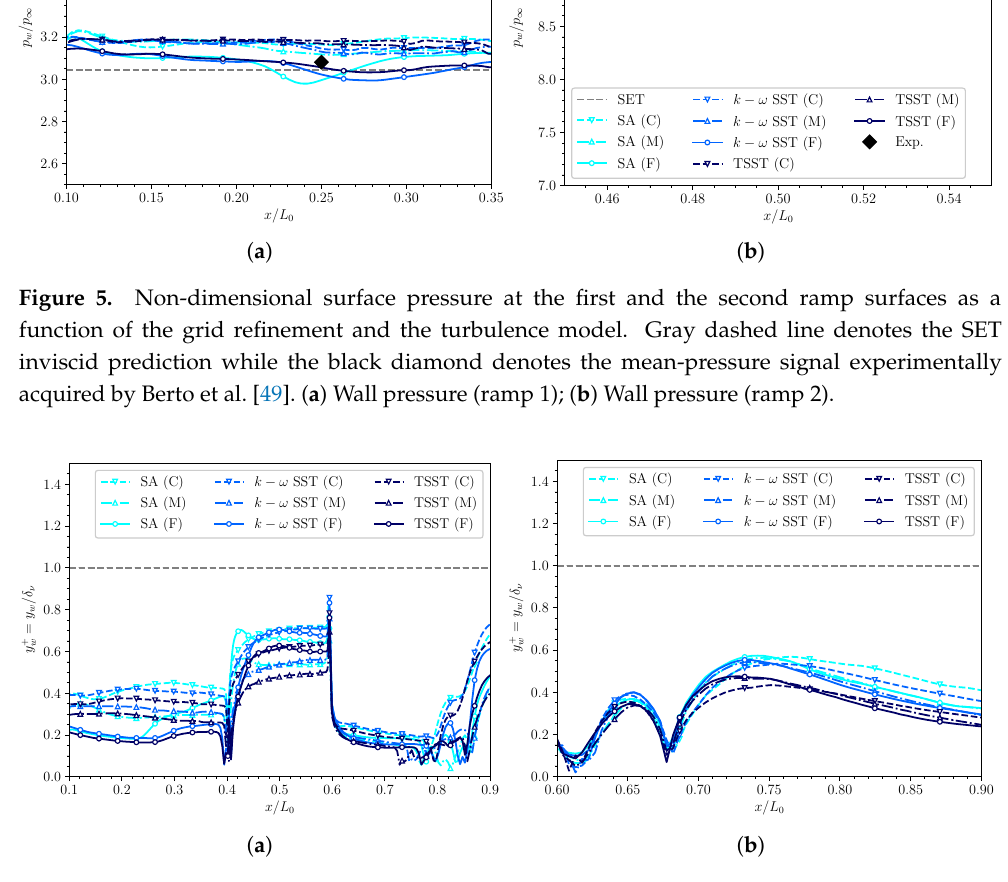
Figure 6. Scaled first off-the-wall cell distance trend as a function of the turbulence model and the mesh refinement level. ( a ) y + w bottom surface ( b ) y + w top surface. Having understood in quantitative terms that the grid can properly capture the velocity and temperature gradients at the wall, Figure 7 reports the comparison of the results p ∞ ) / q ∞ , coefficients as obtained in terms of friction, c f = τ w / q ∞ , and pressure c p = ( p w − a function of the grid level and the turbulence model. Here q ∞ = 1/2 ρ ∞ u 2 ∞ is the freestream pressure load. In particular, Figure 7a,c show the trend of the friction coefficients, while Figure 7b,d show the pressure coefficient along the bottom and the upper channel surfaces,